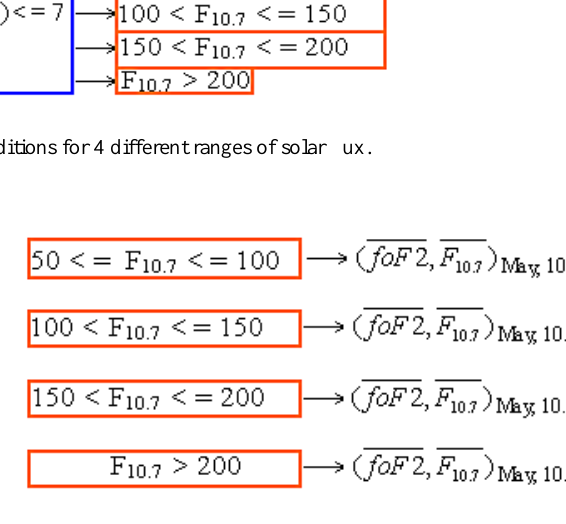
Fig. 2. The mean values of fo F2 and F10.7 are extracted from each range of solar flux selected for a given month (May) and hour